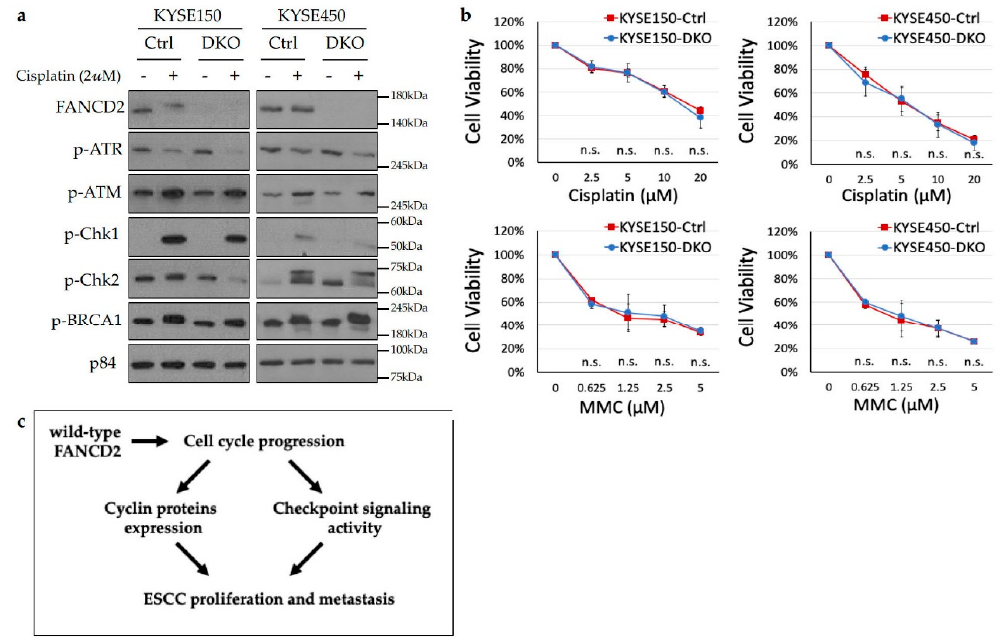
Figure 6. Analysis and schematic diagram of FANCD2 functions. ( a ) Western blotting analysis of checkpoint proteins in response to 2 µ M cisplatin treatment. ( b ) MTT assay on cells treated with cisplatin or MMC for 72 h. The data are shown as the mean ± 95% confidence interval ( n = 3). ( c ) Schematic diagram of FANCD2 conferring a malignant phenotype in ESCC. Ctrl, control; DKO, FANCD2 knockout; n.s., p < 0.05.